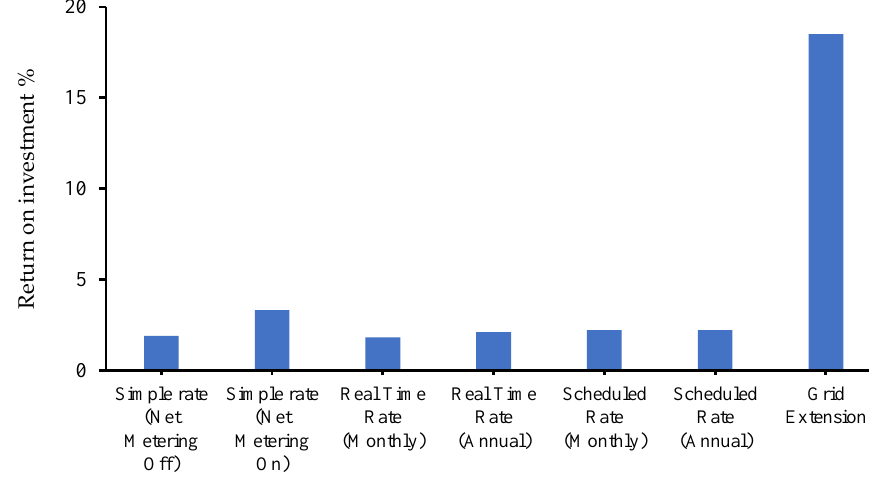
Figure 13. Return on investment (ROI) comparison.